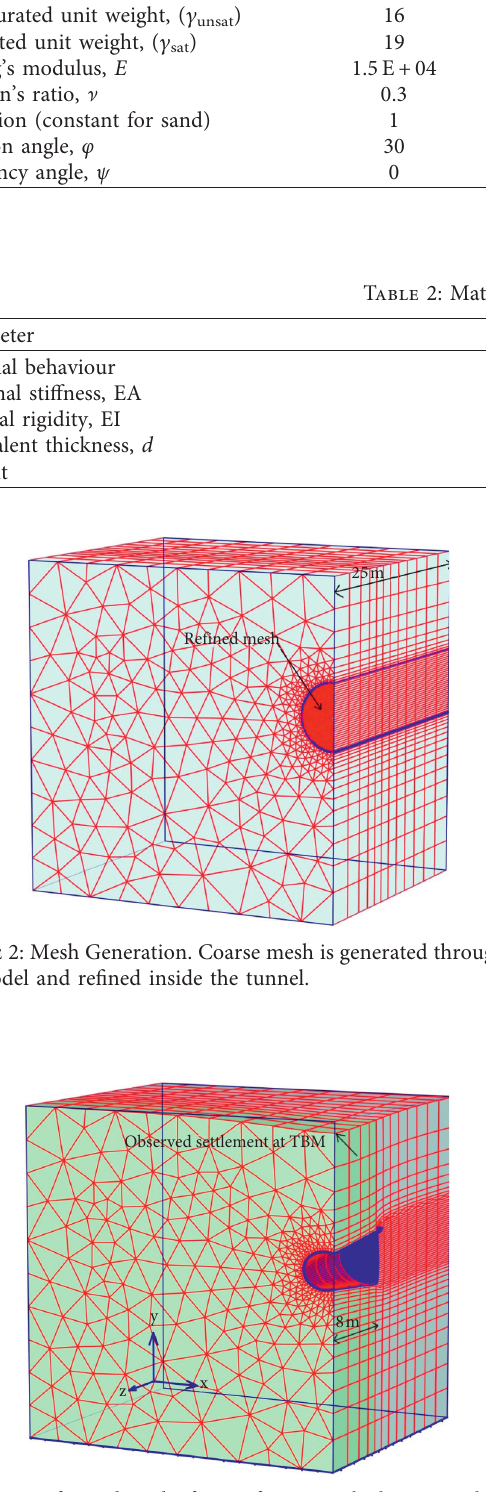
Figure 3: Deformed mesh after performing calculation. Settlement is observed at the surface due to volume loss for first 8m (TBM length).